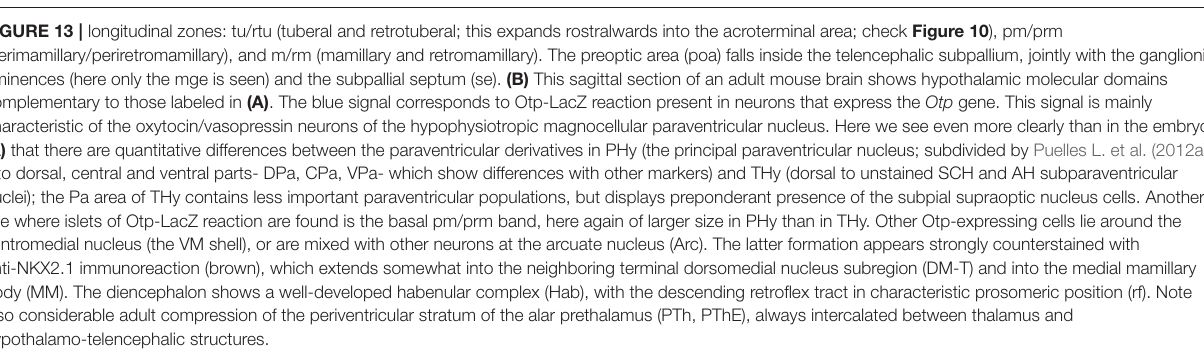
FIGURE 13 | longitudinal zones: tu/rtu (tuberal and retrotuberal; this expands rostralwards into the acroterminal area; check Figure 10 ), pm/prm (perimamillary/periretromamillary), and m/rm (mamillary and retromamillary). The preoptic area (poa) falls inside the telencephalic subpallium, jointly with the ganglionic eminences (here only the mge is seen) and the subpallial septum (se). (B) This sagittal section of an adult mouse brain shows hypothalamic molecular domains complementary to those labeled in (A) . The blue signal corresponds to Otp-LacZ reaction present in neurons that express the Otp gene. This signal is mainly characteristic of the oxytocin/vasopressin neurons of the hypophysiotropic magnocellular paraventricular nucleus. Here we see even more clearly than in the embryo (A) that there are quantitative differences between the paraventricular derivatives in PHy (the principal paraventricular nucleus; subdivided by Puelles L. et al. (2012a) into dorsal, central and ventral parts- DPa, CPa, VPa- which show differences with other markers) and THy (dorsal to unstained SCH and AH subparaventricular nuclei); the Pa area of THy contains less important paraventricular populations, but displays preponderant presence of the subpial supraoptic nucleus cells. Another site where islets of Otp-LacZ reaction are found is the basal pm/prm band, here again of larger size in PHy than in THy. Other Otp-expressing cells lie around the ventromedial nucleus (the VM shell), or are mixed with other neurons at the arcuate nucleus (Arc). The latter formation appears strongly counterstained with anti-NKX2.1 immunoreaction (brown), which extends somewhat into the neighboring terminal dorsomedial nucleus subregion (DM-T) and into the medial mamillary body (MM). The diencephalon shows a well-developed habenular complex (Hab), with the descending retroflex tract in characteristic prosomeric position (rf). Note also considerable adult compression of the periventricular stratum of the alar prethalamus (PTh, PThE), always intercalated between thalamus and hypothalamo-telencephalic